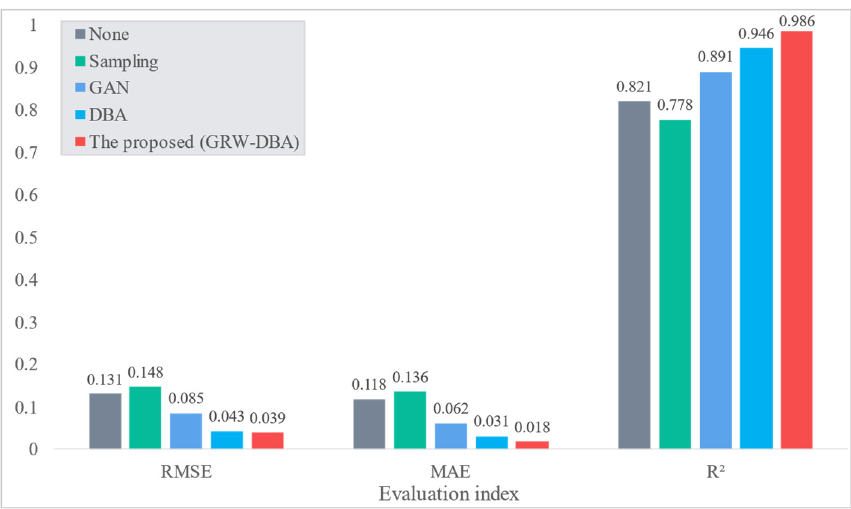
Figure 8. Comparison of the prediction accuracy of models trained on augmented data obtained using the GRW-DBA method proposed in this paper and other classical methods.